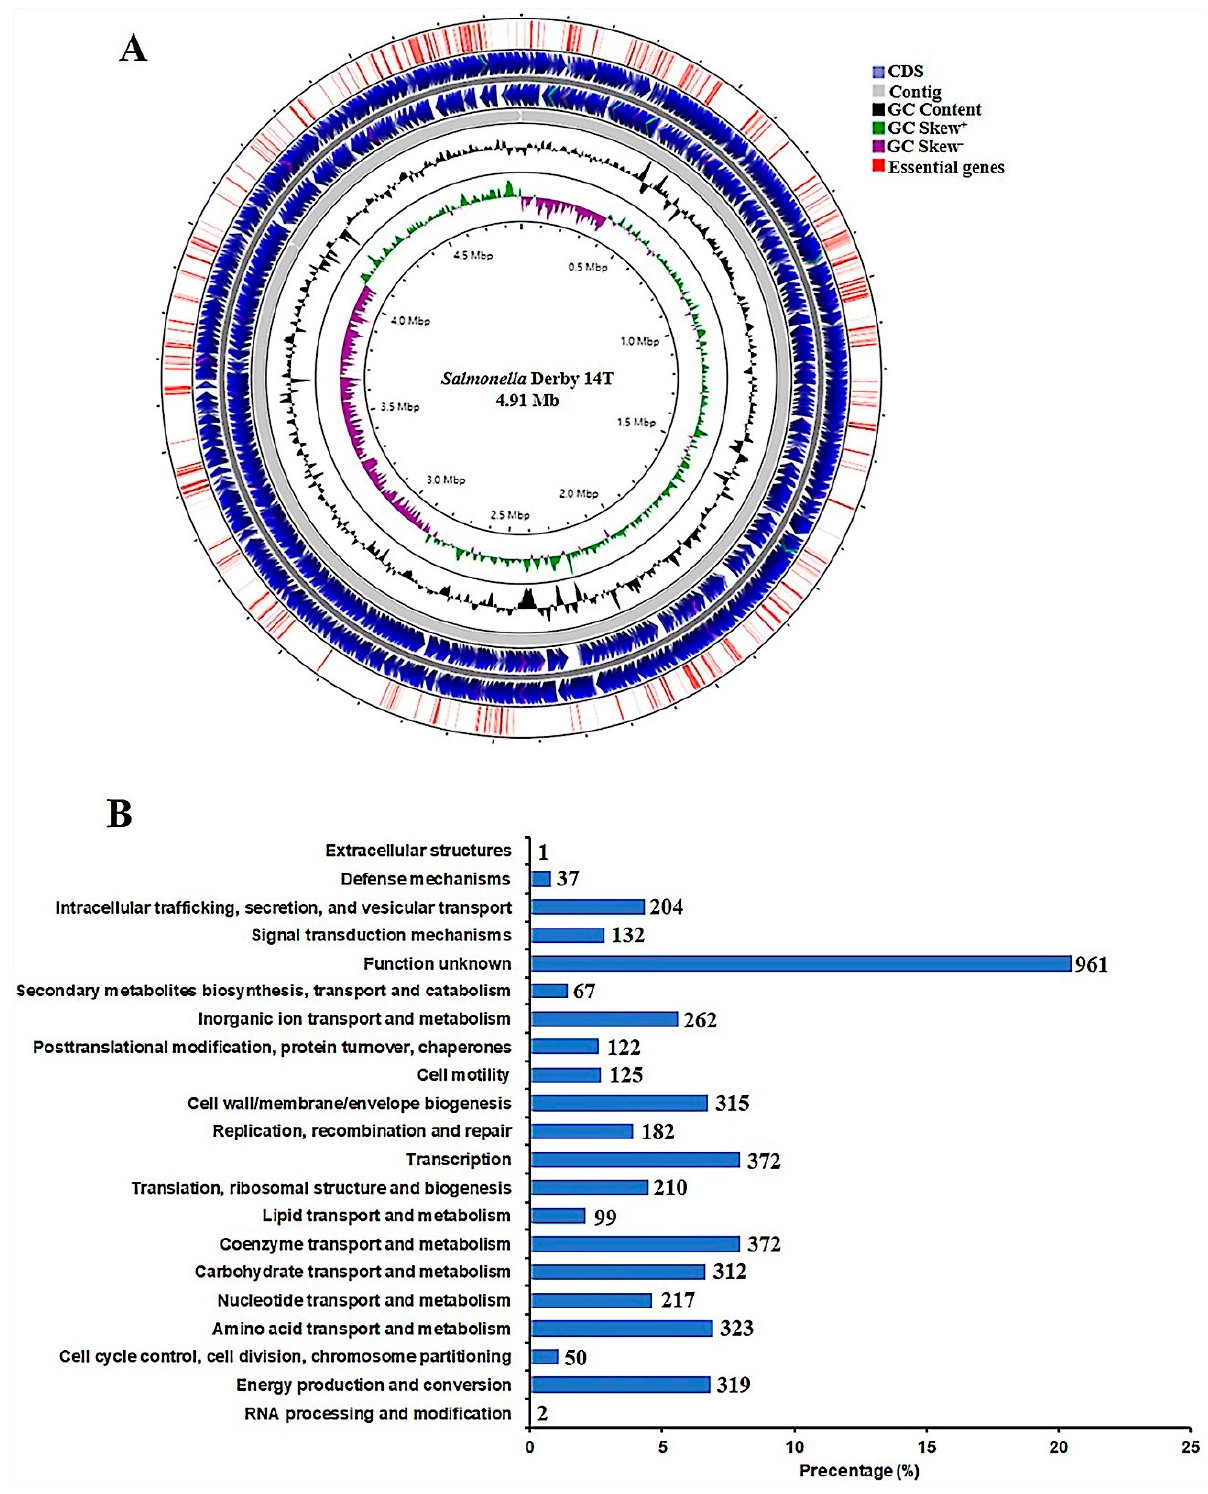
Figure 1. Overview of the Salmonella Derby 14T genome. ( A ) Circular representation of the S . Derby 14T genome. The contents of the feature rings (starting with the innermost ring) are as follows: GC skew, GC content, CDS on the two strands, and the distribution of 581 conditional essential genes. ( B ) COG annotation of genes in the genome of S . Derby 14T. The y-coordinate denotes the COG terms, and the x-coordinate is the percentage of genes affiliated with the term in the total annotated genes.